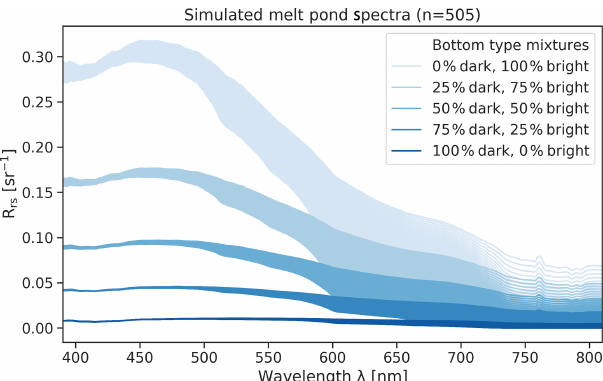
Figure 6. LUT generated with WASI-2D. Each of the five bottom type mixtures consists of 101 spectra (0 to 100cm in 1cm